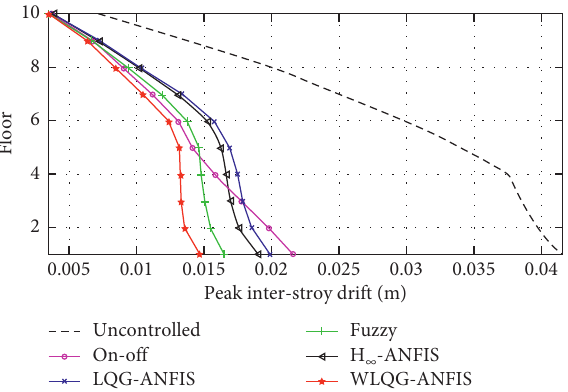
Figure 10: Comparison of the interstory drifts of all the floors among different control